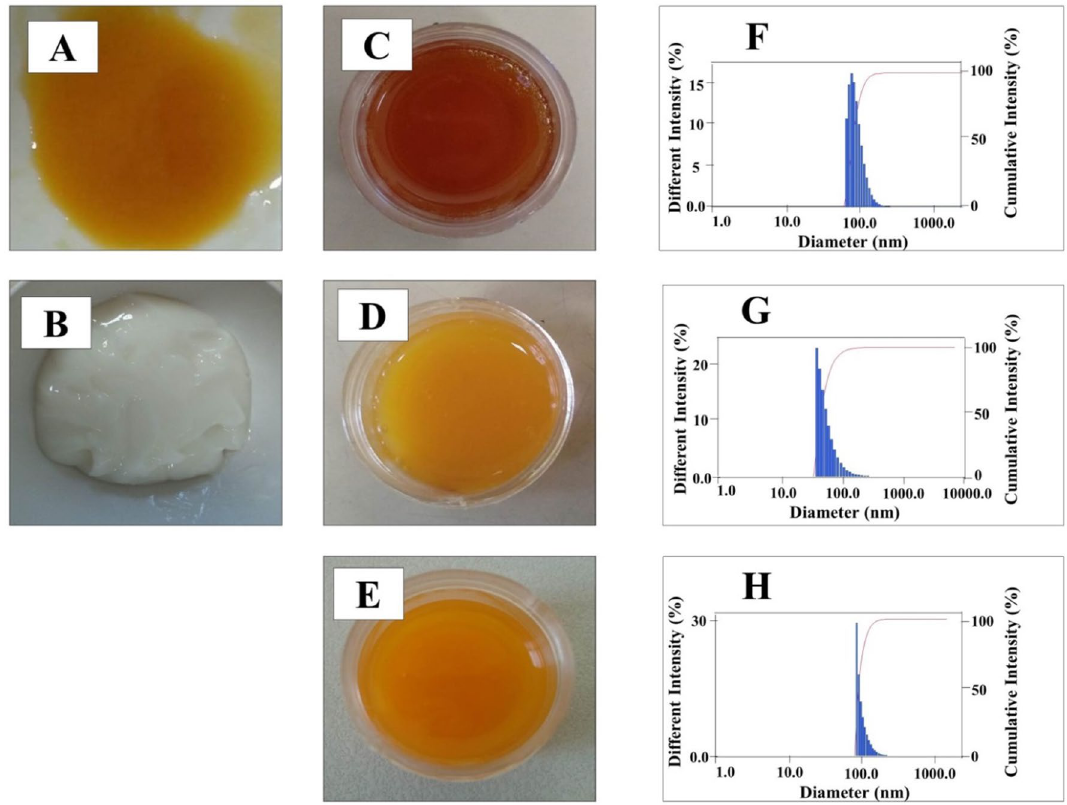
Figure 2. Visual appearance of protransfersomal CoQ10 (Protransf-CoQ10) ( A ), emulgel base ( B ), protransfesomal CoQ10 (Protransf-CoQ10) Emulgel ( C ), CoQ10 dissolved in oleic acid (CoQ10-Ole) Emulgel ( D ), and CoQ10 loaded in emulgel (CoQ10 Emulgel) ( E ). The Intensity distribution of particle of protransfesomal CoQ10 (Protransf-CoQ10) Emulgel ( F ), CoQ10 dissolved in oleic acid (CoQ10-Ole) Emulgel ( G ), and CoQ10 loaded in emulgel (CoQ10 Emulgel) ( H